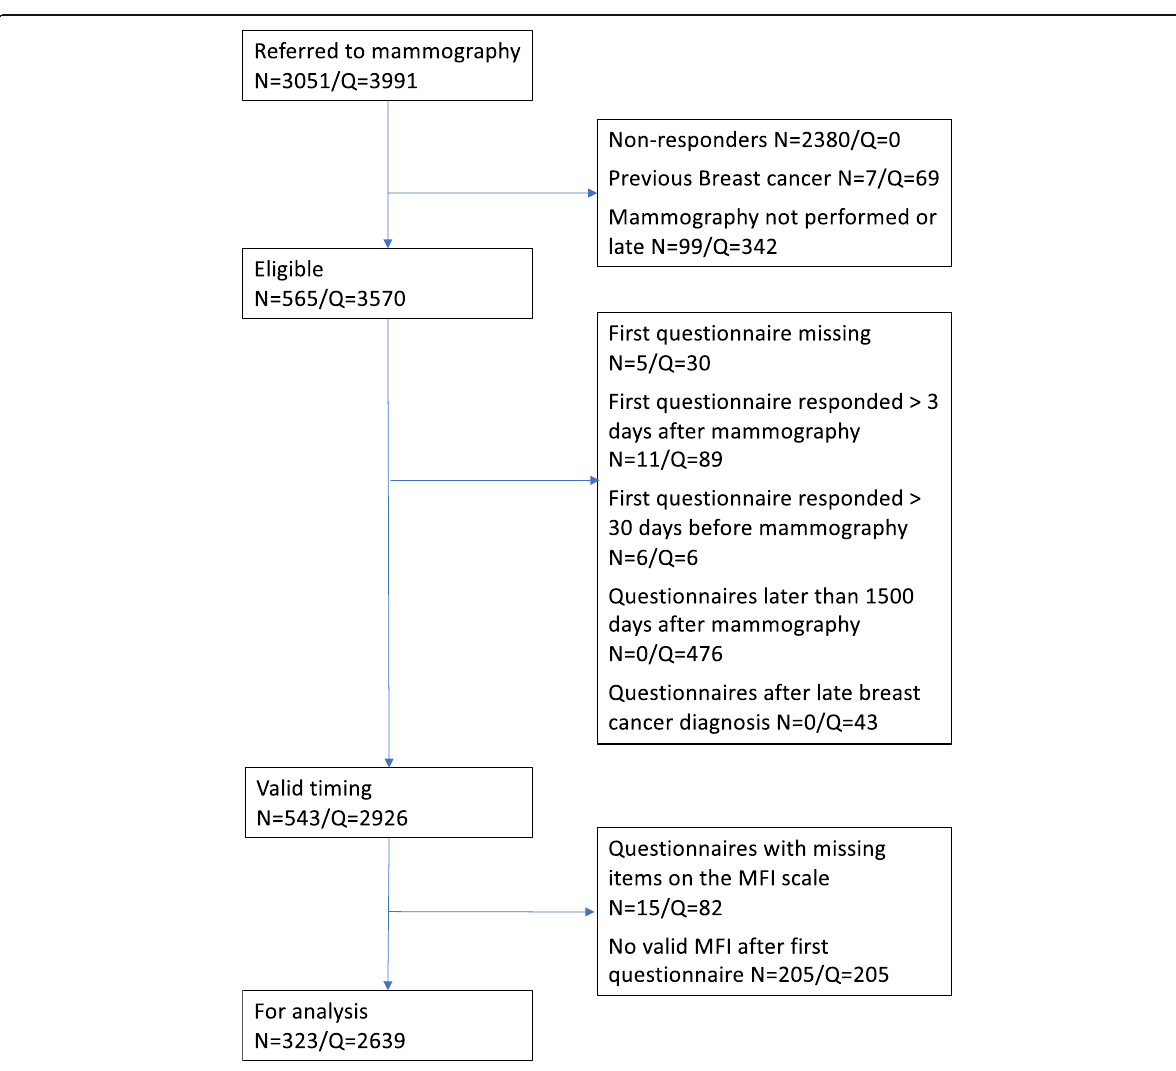
Fig. 1 Flowchart of inclusion of participants and questionnaires in a study of long-term fatigue after breast